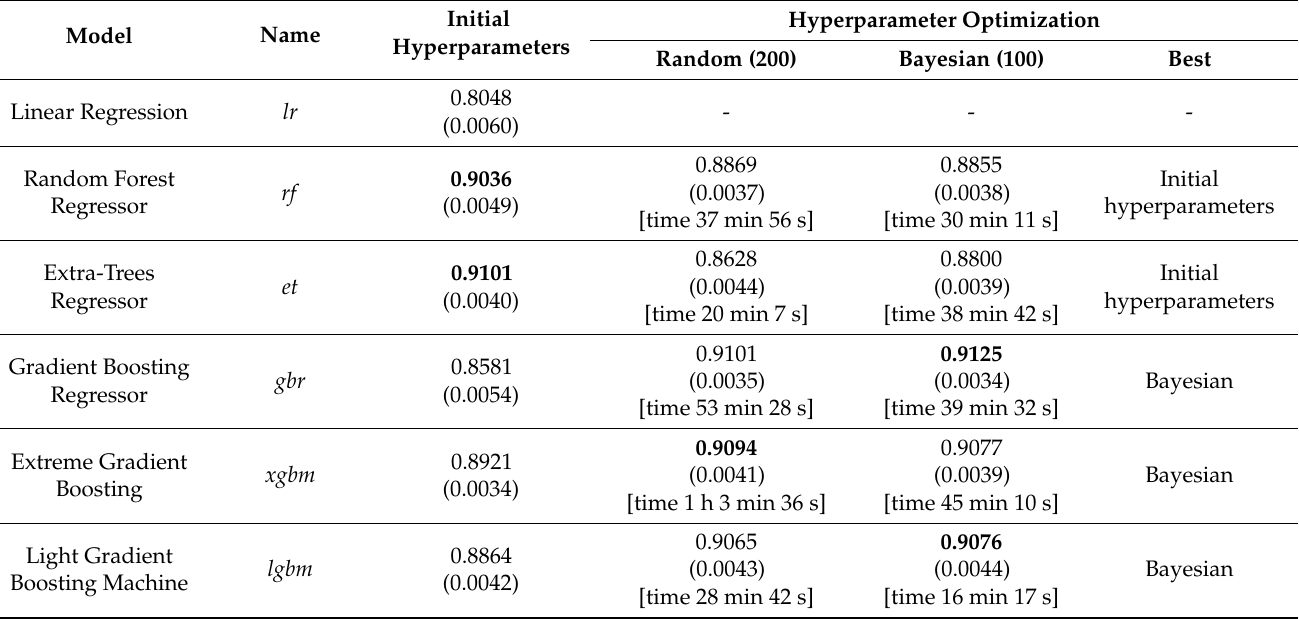
Table 4. Results from the initial performance and hyperparameter adjustment by cross-validation (R 2 score in CV-validation and standard deviation in parentheses).